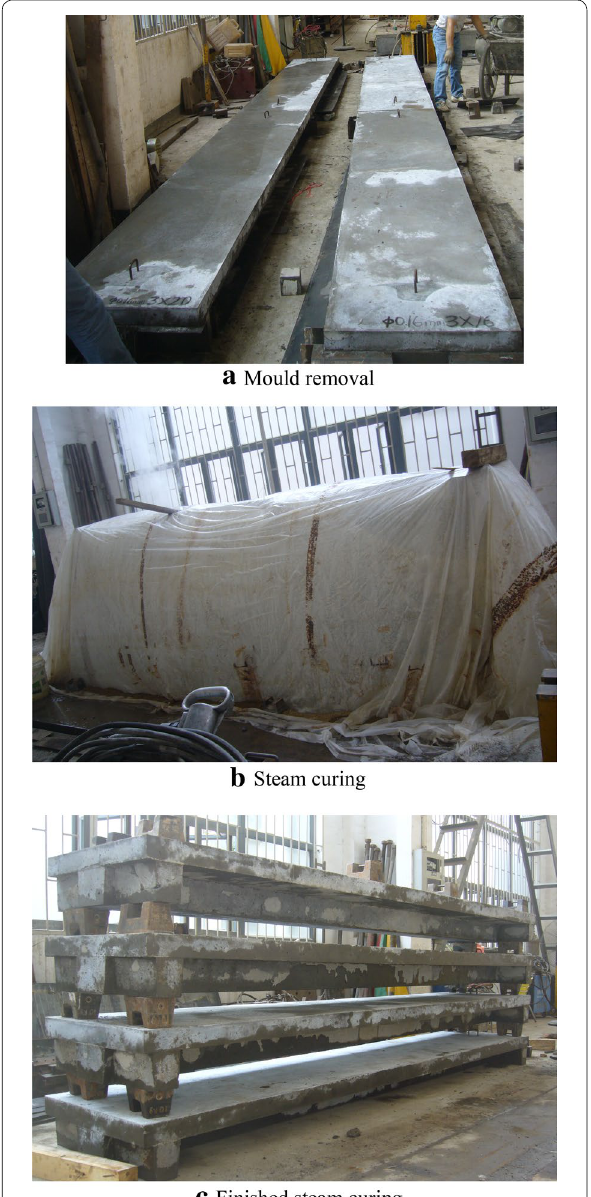
Fig. 5 Process of steam curing.